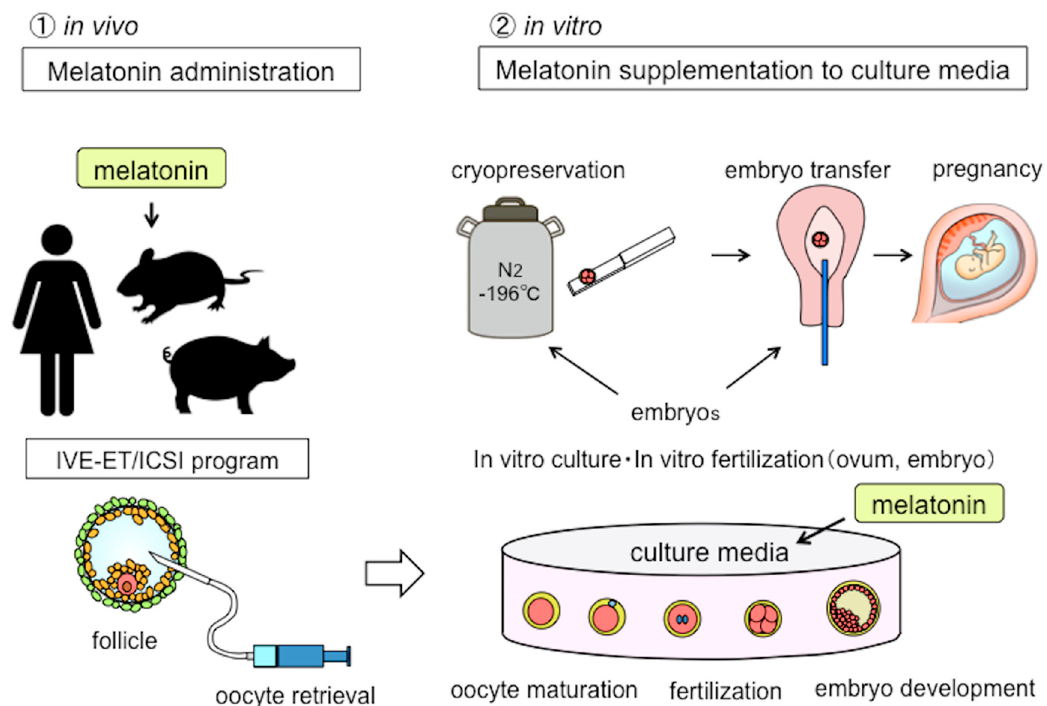
Figure 2. The potential applications of melatonin in human reproduction. Since the application of melatonin has antioxidant effects in reproductive medicine, there are two possibilities. One is that in vivo melatonin administration to patients before ovulation may improve the oocyte quality. Another possibility is melatonin supplementation added to in vitro culture media to enhance oocyte maturation, fertilization, and embryonic development. IVF-ET: in vitro fertilization and embryo transfer, ICSI: intra-cytoplasmic sperm injection.